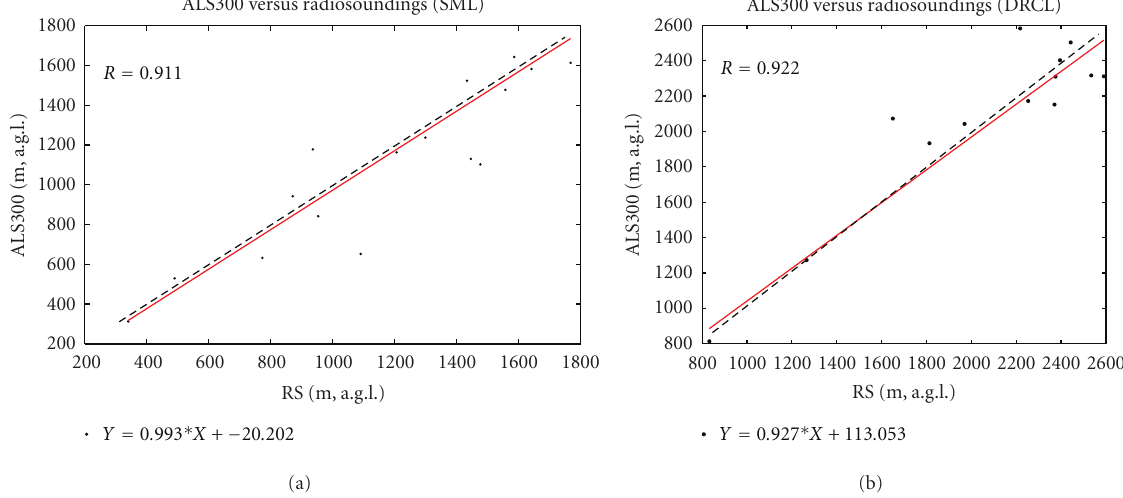
Figure 6: ALS300-RS comparison and linear correlation for SML and DRCL heights.